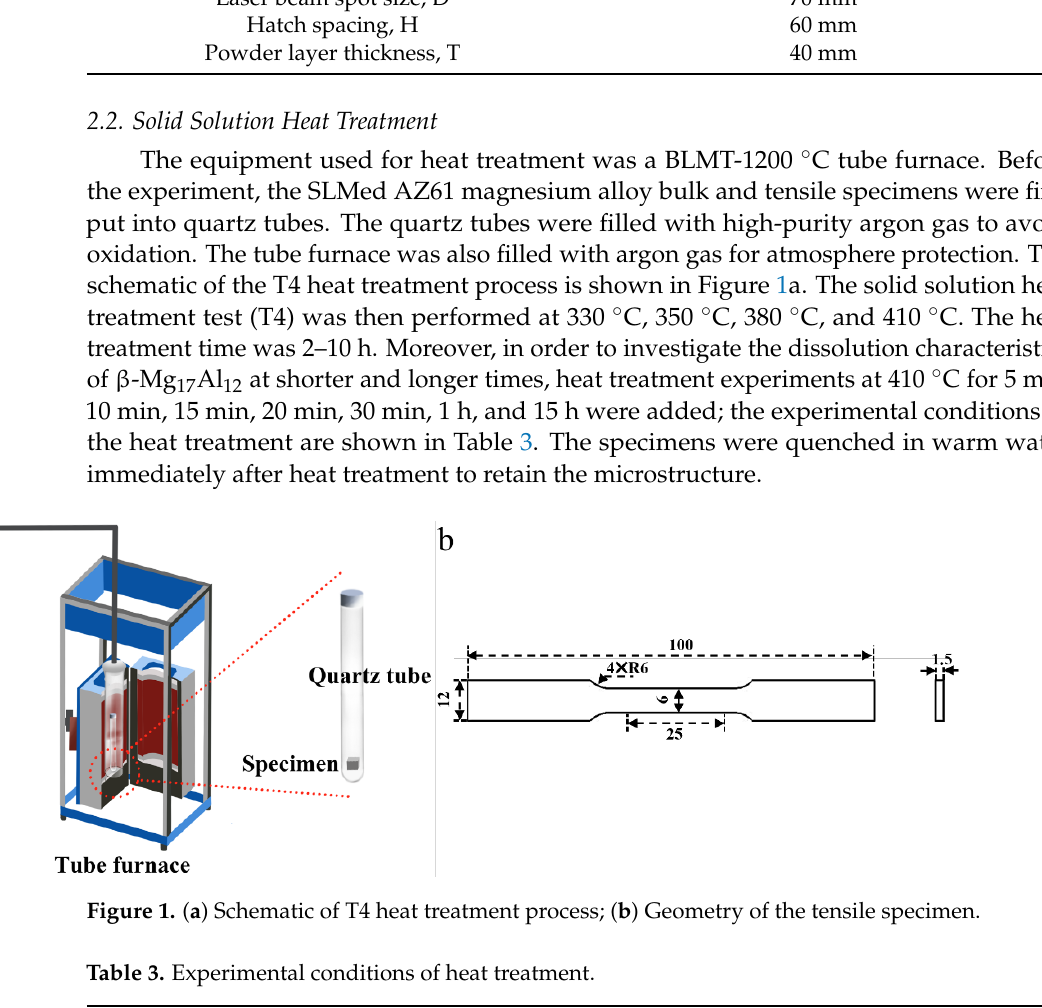
Table 1. The chemical composition of AZ61.